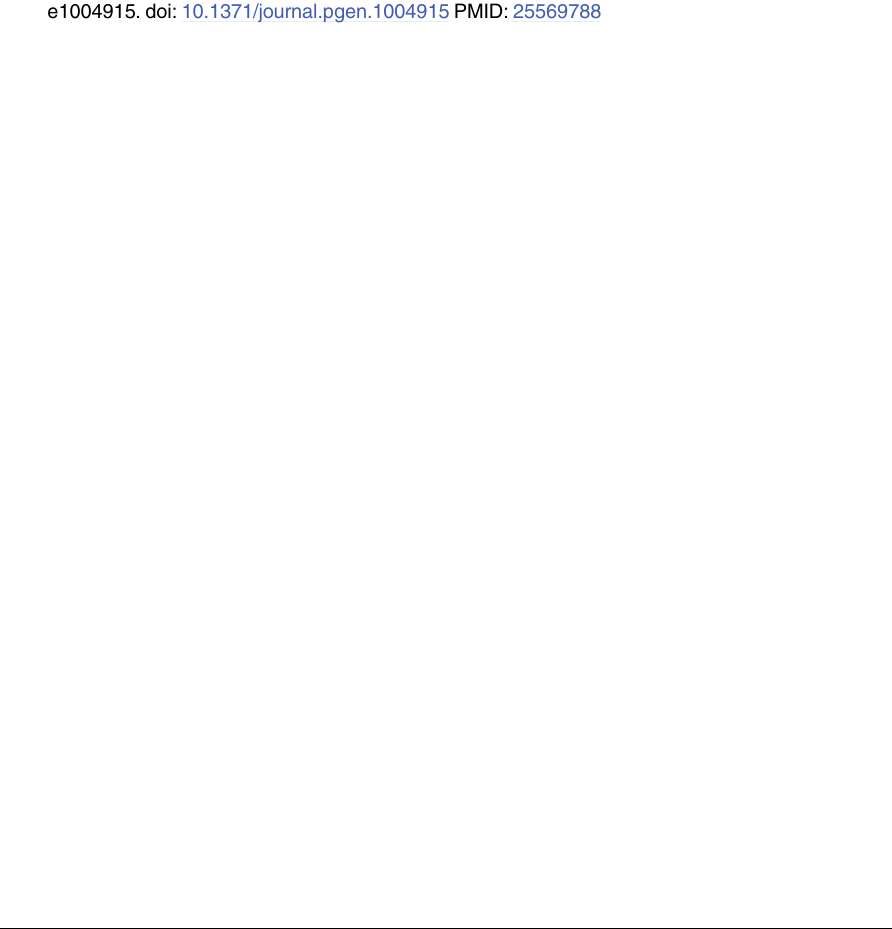
The SRA accession numbers in S1 Table are incorrect. Please view the correct S1 Table below. Supporting Information S1 Table. Sequencing depth for the samples used in this